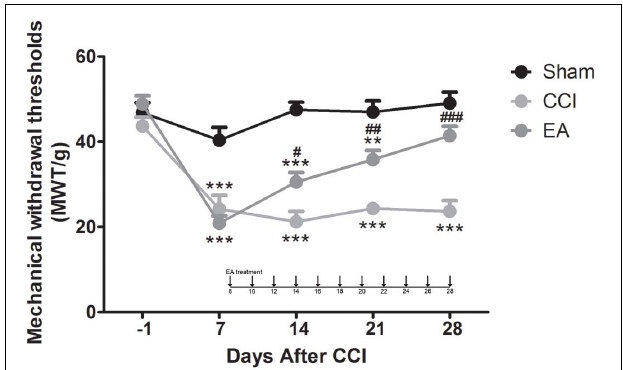
FIGURE 1 | The effects of electroacupuncture (EA) on mechanical allodynia induced by chronic constrictive injury (CCI) in Sprague-Dawley (SD) rats. EA treatment was applied at day 8 after CCI. The rats received EA stimulation once every other day for 8–28 days (total of 11 times). Evaluations of mechanical withdrawal thresholds in the sham group, CCI-induced neuropathic pain (NeuP) model group (CCI group), and CCI-induced NeuP model with EA treatment group (EA group). All data are expressed as the mean ± SEM ( n = 13 per group). ** p < 0.01, *** p < 0.001 vs. the sham group; # p < 0.05, ## p < 0.01, ### p < 0.001 vs. the CCI